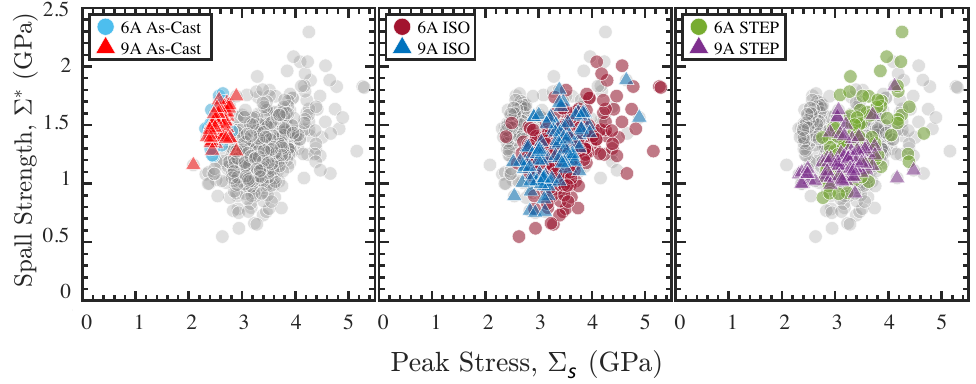
Figure A2. Spall strength vs. peak shock stress results for all sample sets. Each frame compares composition-based results for the same processing conditions: ( left ) As-Cast, ( center ) ISO, and ( right ) STEP. The full dataset is shown in the background in grey for direct